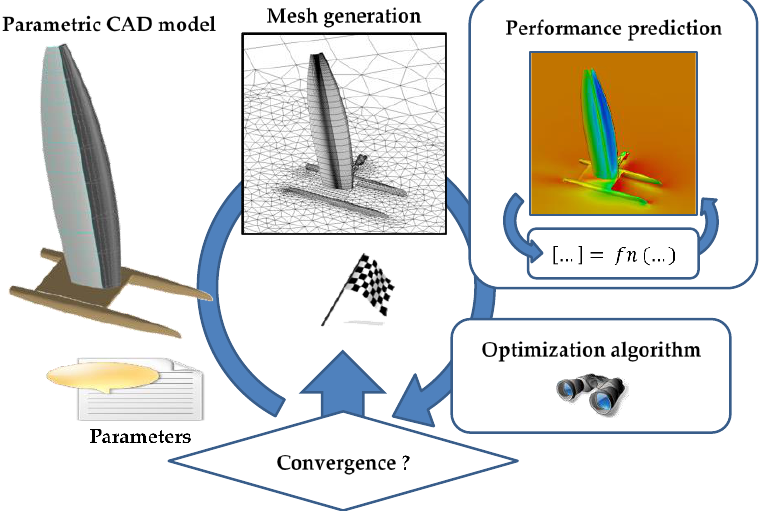
Figure 25. Scheme of the optimization procedure.